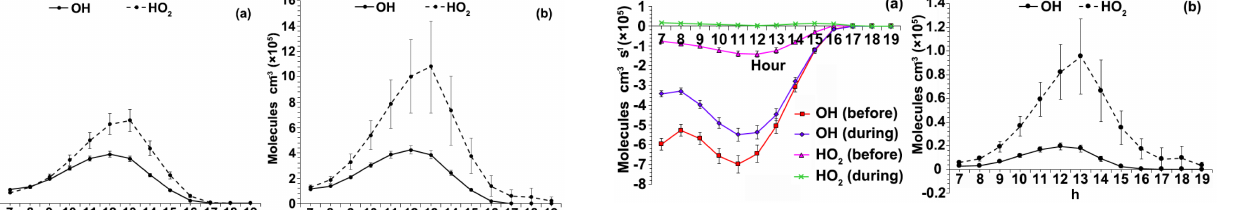
Figure 9. Daytime patterns of OH and HO 2 (a) before and (b) dur- ing the program.